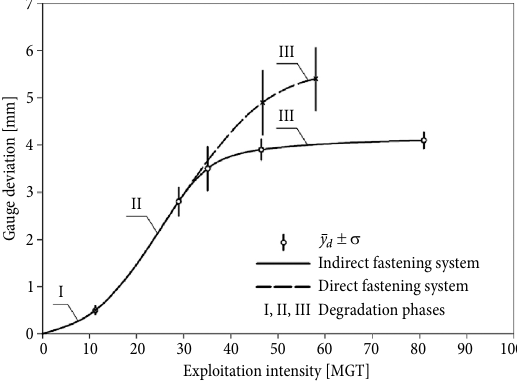
Fig. 5. Observed gauge degradation